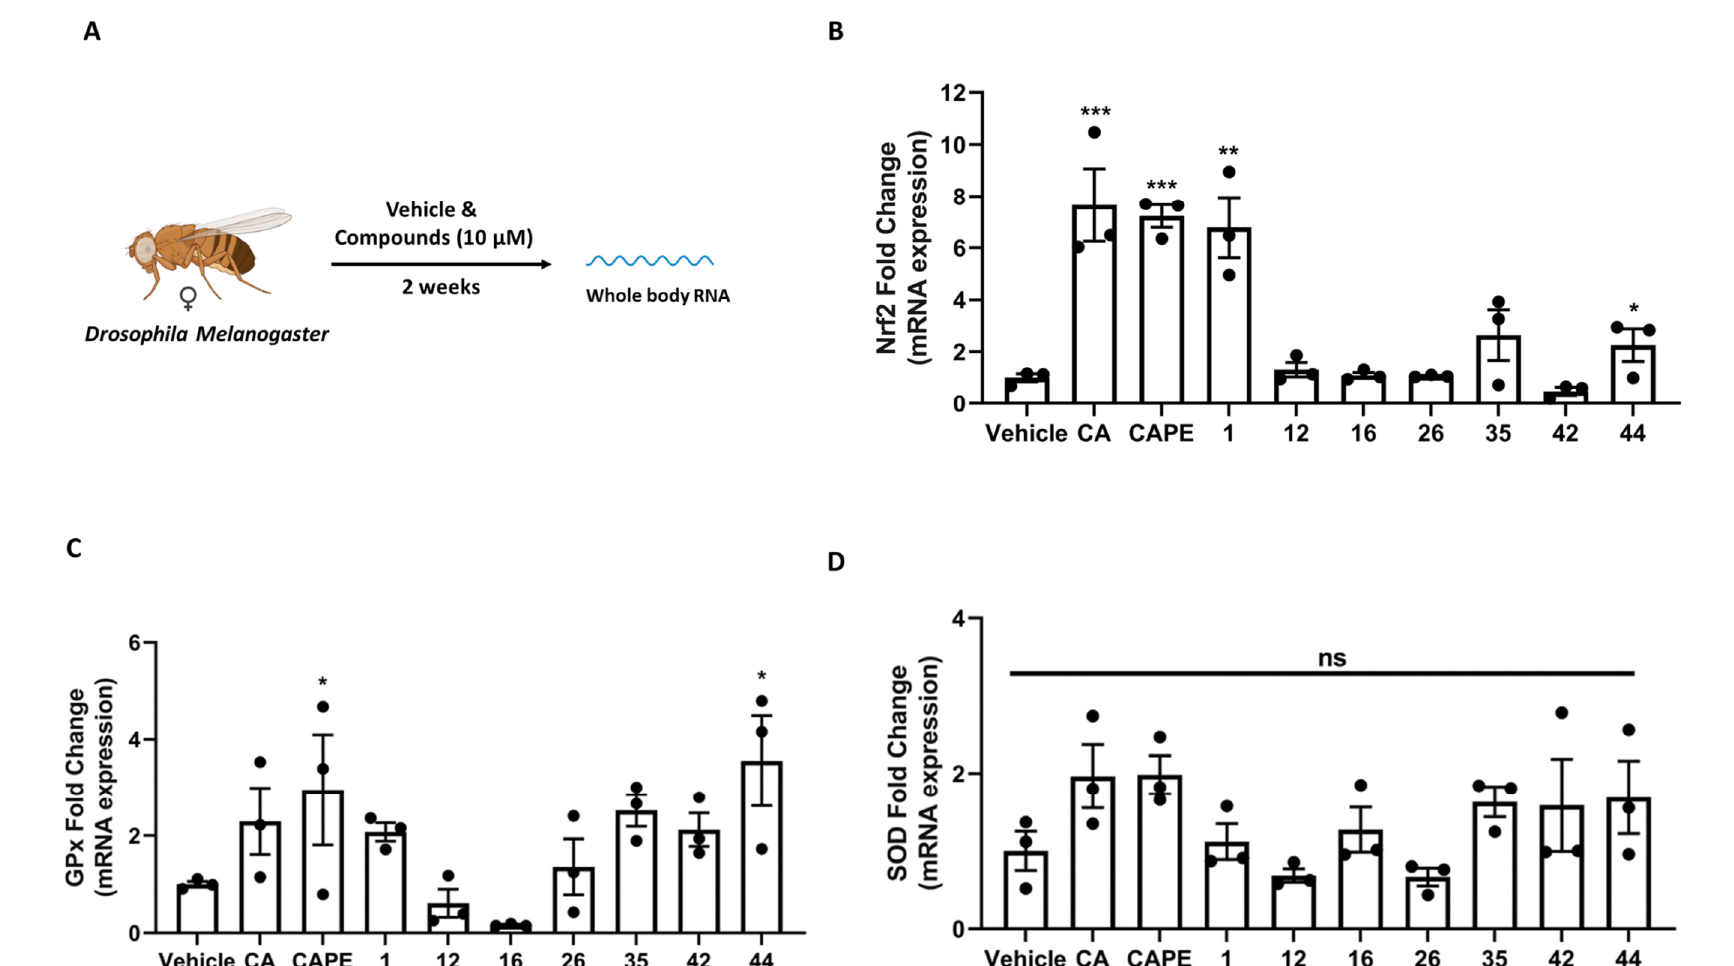
Figure 6. The impact of Caffeic acid and CAPE analogs on Nrf2 pathway activation in Drosophila Melanogaster . ( A ) The virgin yellow white ( yw ) mutant female flies were fed the selected compounds for 2 weeks (10 µ M) and then the total RNA was extracted using TRIzol. Changes in ( B ) Nrf2 ( C ) GPx ( D ) SOD mRNA levels were analyzed. Ordinary one-way analysis of variance (ANOVA) was performed followed by Dunnett’s multiple comparisons test to identify statistical difference * p < 0.05, ** p < 0.01, *** p < 0.001, ns: non-significant.